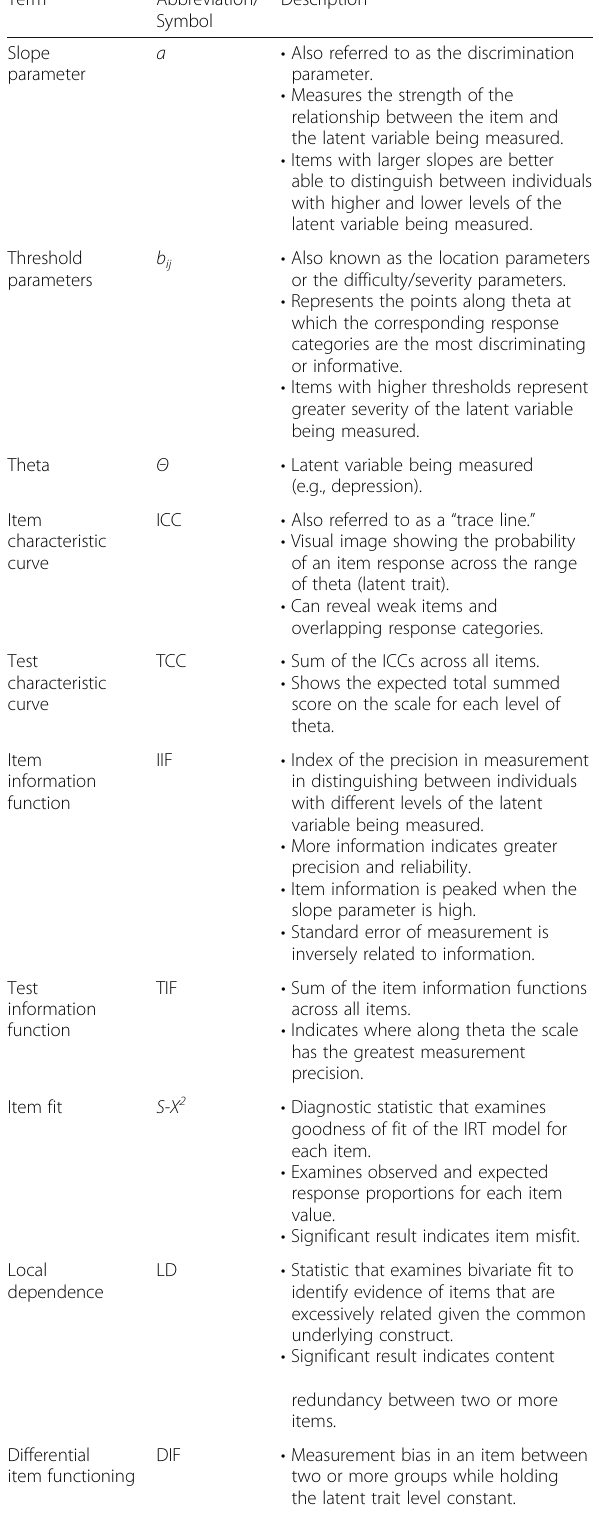
Table 1 Common terms used in an IRT graded response